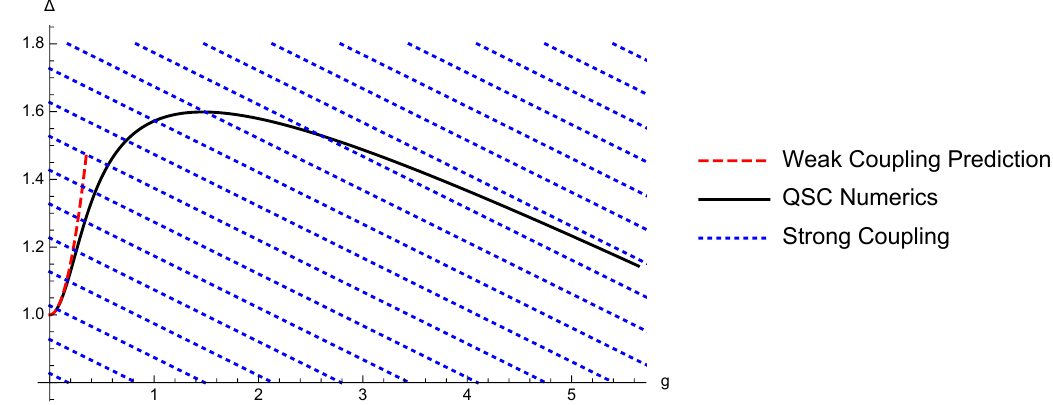
Figure 4 . This plot shows our numerical data for the case (cid:30) = (cid:25)= 4 and (cid:18) = (cid:25)= 8. The dashed red line represents the one-loop result at weak coupling, which we conjecture to take the form (cid:1)( g ) = 1 + 4 g 2 cos 2 ( (cid:18)= 2) + O ( g 4 ), consistent with both the ladders limit and (cid:18) ! 0. The dotted blue lines represent the slope of the classical strong coupling result of [26]. The solid black line represents the numerical data obtained with the